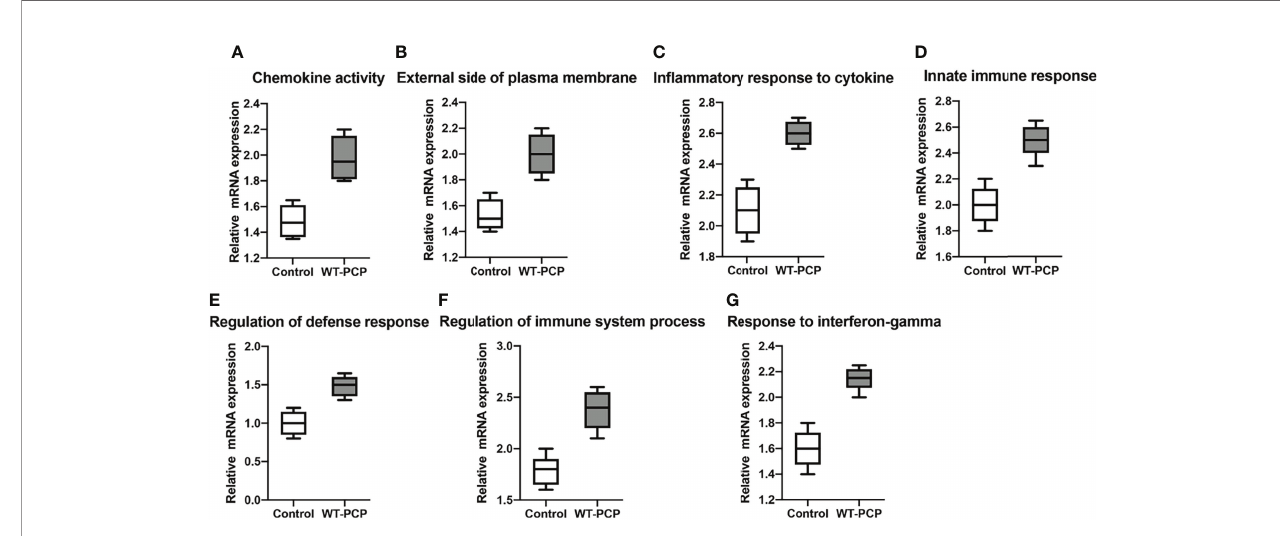
FIGURE 8 | Box-and-whisker plots of the relative mRNA expression values in the WT-PCP mice compared with the uninfected mice. The genes included were related to the respective pathways, including the chemokine activity (A) , external side of plasma membrane (B) , in fl ammatory response to cytokine (C) , innate immune response (D) , regulation of defense response (E) , regulation of immune system process (F) , and response to interferon-gamma (G) . All P < 0.05.